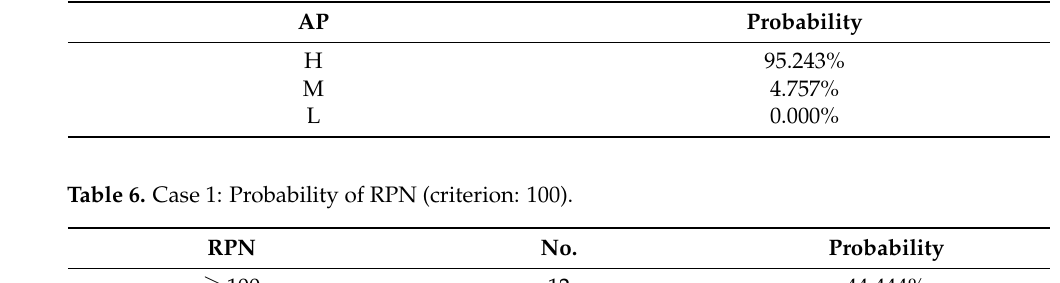
Table 5. Case 1: Probability statistics of AP.